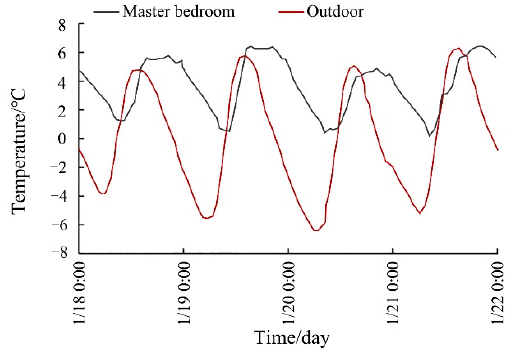
Figure 12. The simulated temperature before the renovation.